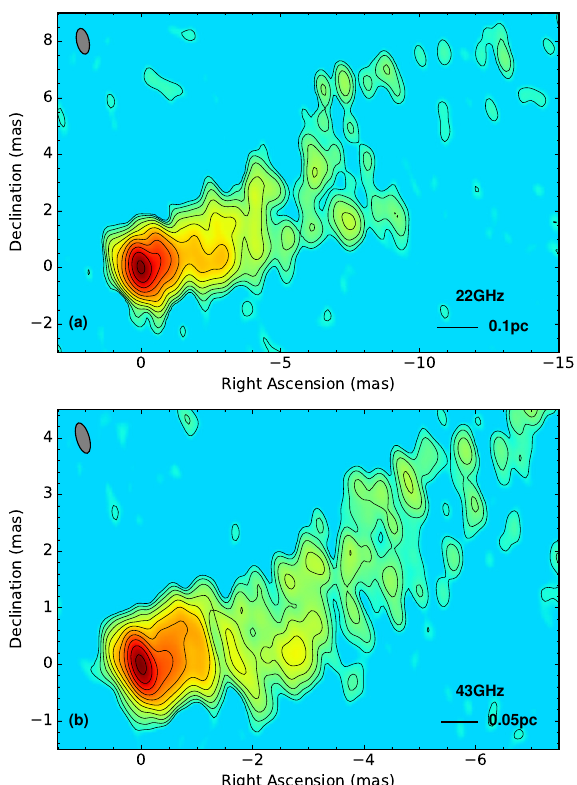
Figure 1. 22 and 43 GHz contour plots overlapping with pseudo-color images of the same frequency respectively, with the synthesized beam shown at the top-left corner of each panel. Panel ( a ) shows the image of M87 at 22 GHz with a synthesized beam of 0.93 0.45 mas at a position angle of 12.6 ◦ ; contours × in this image are from ( 1, 1, 2, 4, 8...) 0.86 mJy beam − 1 . Panel ( b ) shows the image of M87 at 43 GHz − × with a synthesized beam of 0.56 0.23 mas at a position angle of 16.7 ◦ ; contours in this image are from × ( 1, 1, 2, 4, 8...) 0.54 mJy beam − 1 − ×